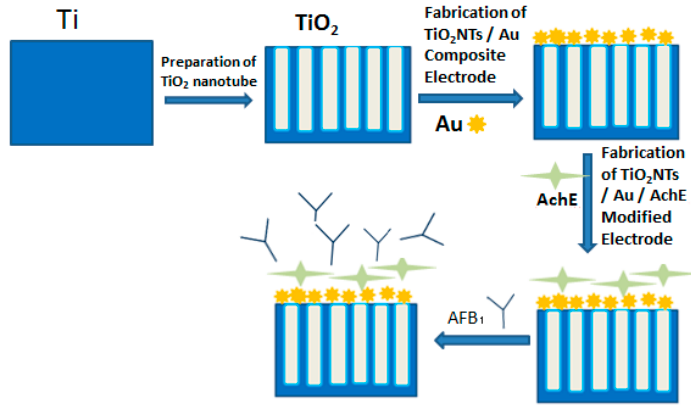
Scheme 2. The schematic diagram of the biosensors assembly procedure.